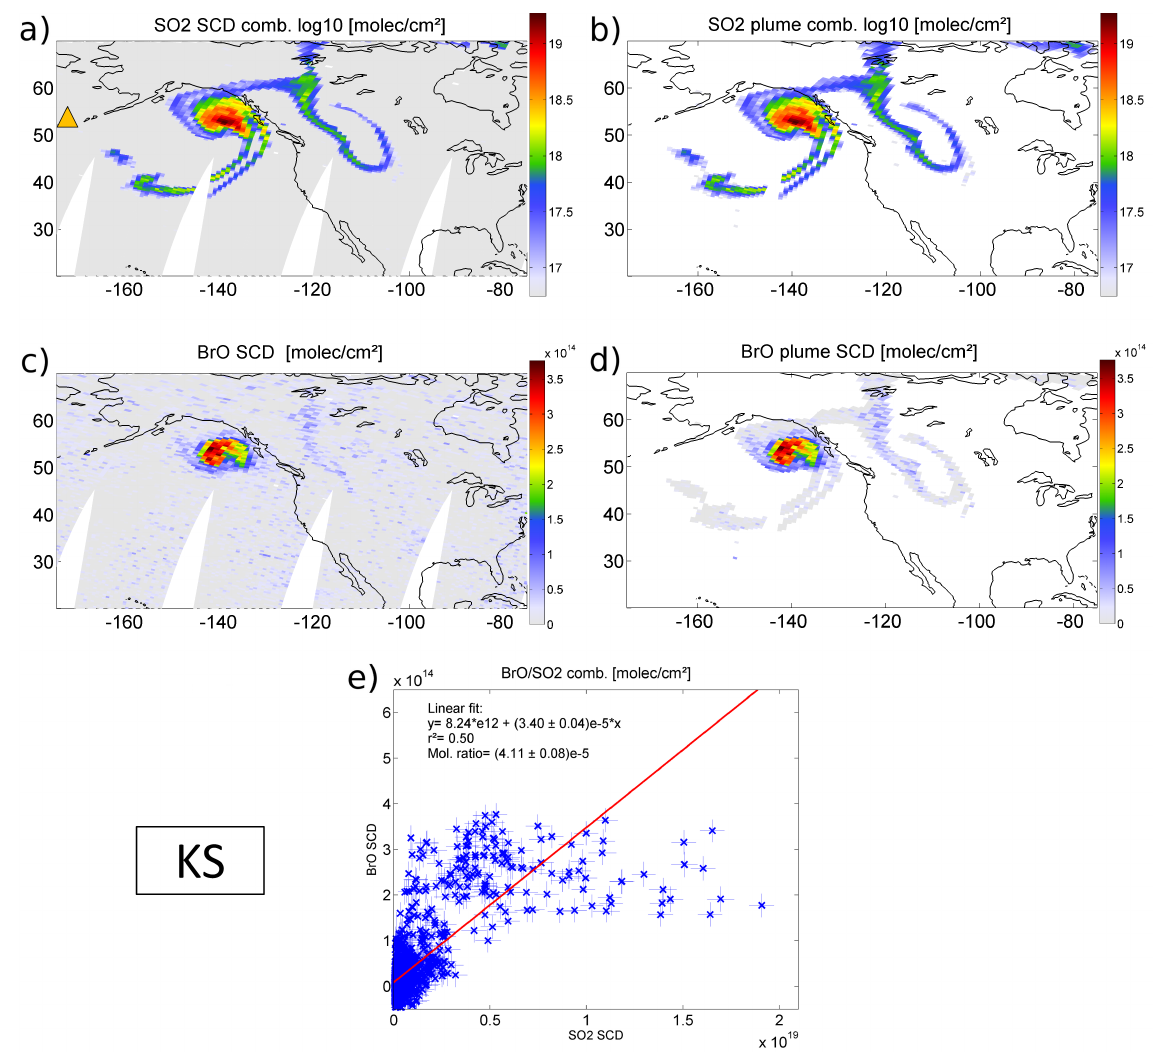
Fig. 12. GOME-2 maps for SO 2 and BrO for the volcanic plume of Kasatochi on 11 August 2008. The centre part of the plume has further travelled in eastern direction, several branches now extend from the plume centre in south western and north eastern direction ( a and b ). The enhanced BrO SCDs ∗ are located around the centre region, but the distribution inside this area remains different compared to the one for SO 2 ( c and d ), as the highest SO 2 SCDs ∗ appear directly in the plume centre, while the BrO seems to be twisted around it. This can also be seen in the correlation plot (e) , where the BrO columns are independently scattered around 2.5 × 10 14 for SO 2 SCDs ∗ > 5 × 10 18 moleccm − 2